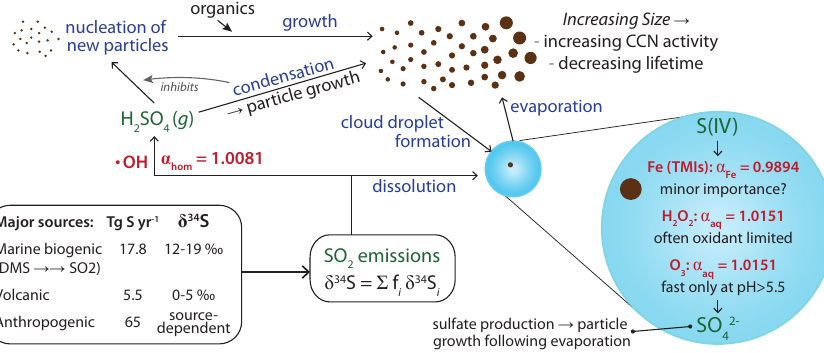
Fig. 11. A summary of sulfur isotopes and the continental sulfur cycle. Fractionation factors are shown for 19 ◦ C. Emission quantities for the different sources are taken from Sofen et al. (2011) and δ 34 S values of sources are from Rees et al. (1978), Krouse et al. (1991), Nielsen et al. (1991) and Sanusi et al.